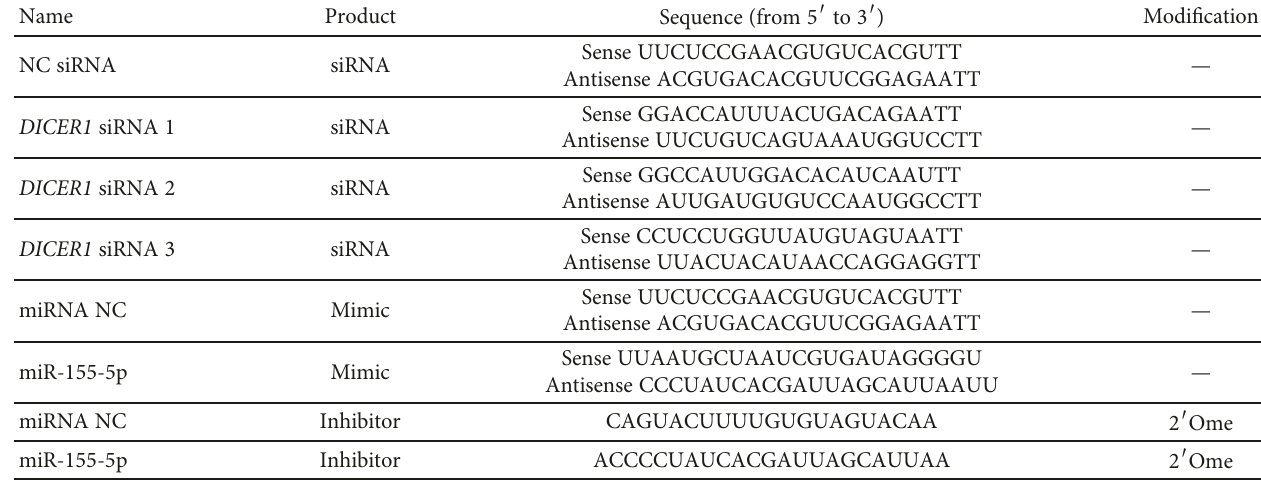
Table 1: Human DICER1 siRNA, miR-155 mimic/inhibitor product sequence information.